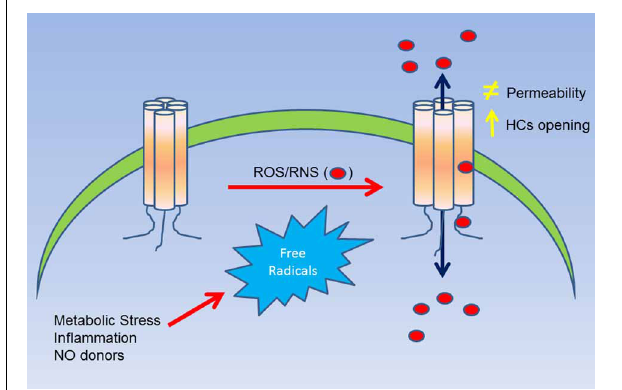
FIGURE 1 | Summary of the effect of ROS/RNS over Cxs hemichannels. A cellular stress (i.e., metabolic inhibition) induces an increase of ROS/RNS production, which in turn, can affect directly Cx hemichannels (as observed in Cys271 of Cx43). This molecular modification can induce and increase in the open probability of hemichannels and/or changes in their permeability to large molecules. Additionally, the posttranslational modification induced by ROS/RNS can also lead to an increase of the permeability of nitro oxide and possibly of other free radicals as